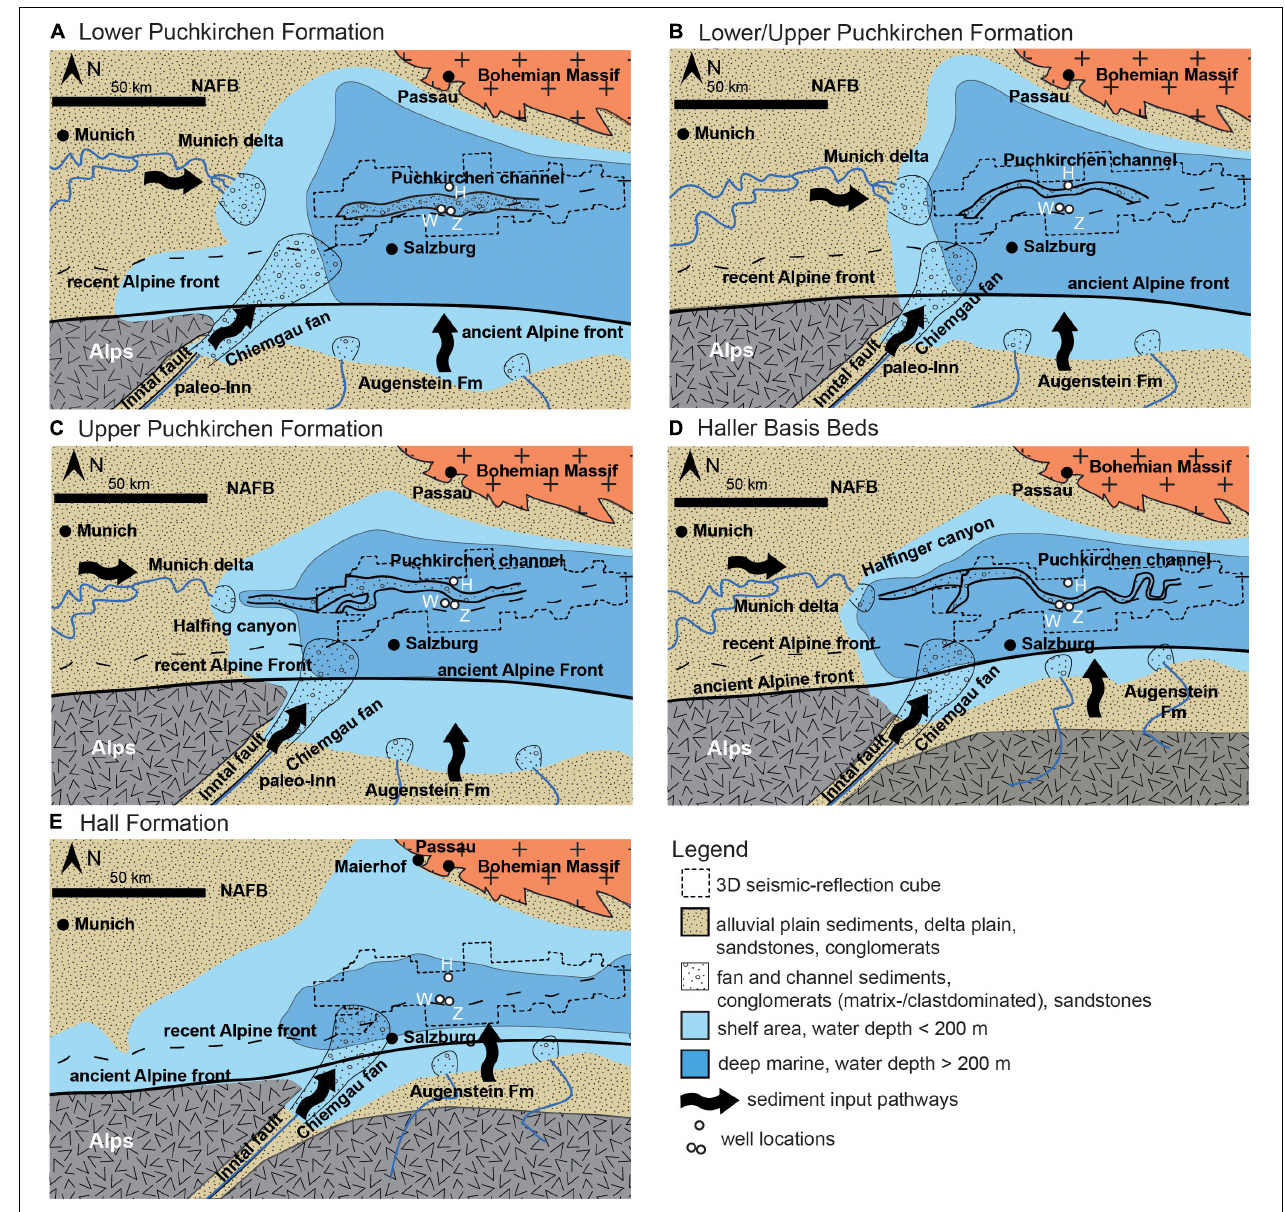
FIGURE 4 | Paleogeographic reconstructions of the Upper Austrian and SE German NAFB during the late Oligocene through Early Miocene (A–E) and their main sediment input pathways. Channel geometries were mapped in the 3D seismic cube. Information compiled from Reiser (1987); Wenger (1987), Lemcke (1988); Zweigel (1998), Kuhlemann and Kempf (2002), and Grunert et al. (2013). During the deposition of the LPF (A) the channel shows a low sinuosity and is located at the southern basin margin. The Puchkirchen Trough was fed from the paleo-Inn, the Augenstein deposits, and the Munich delta from which clinoforms prograded into the basin, the shoreline moved to the east. At the L/UPF boundary (B) the shoreline reached its easternmost position, the channel started to meander and reached its northernmost position. In the UPF (C) the depositional system on the Bavarian Shelf changed, the Halfing canyon developed and was connected to the Puchkirchen channel. The shoreline was located further to the west compared to (B) . During the formation of the BHU (D) a major sea-level fall occurred and the channel acquired its highest sinuosity; the Halfinger canyon was still active. In the HFM (E) the sedimentation system in the Molasse Basin changed completely due to reestablishment of marine conditions in the western NAFB (Upper Marine Molasse), channel sedimentation ended and clinoforms started to prograde into the basin from the